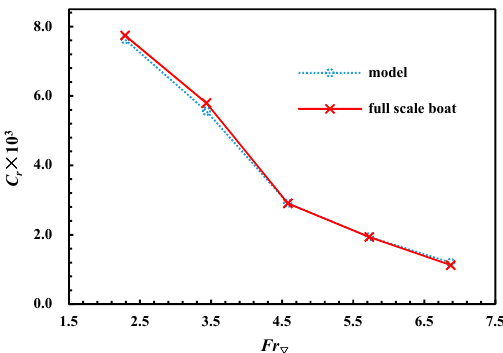
Figure 14. Residual resistance coefficient of stepped planing hull in both model and full scale.